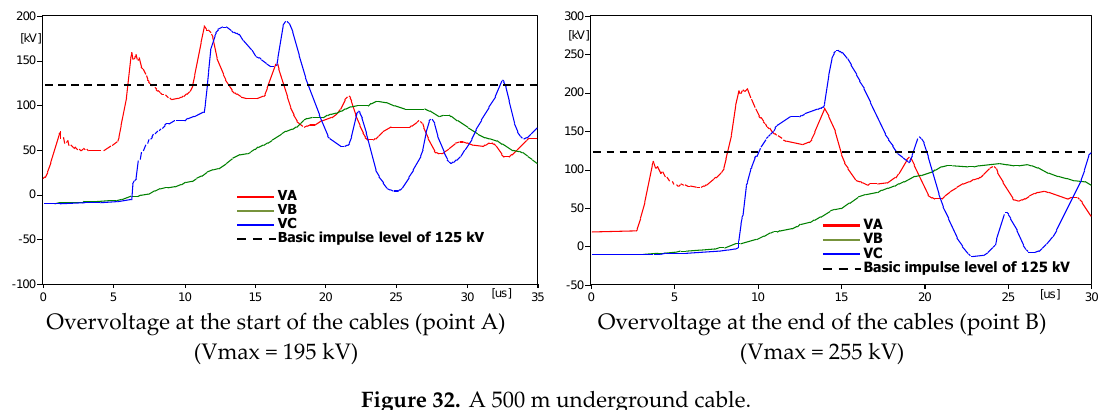
Figure 31. A 400 m underground cable.